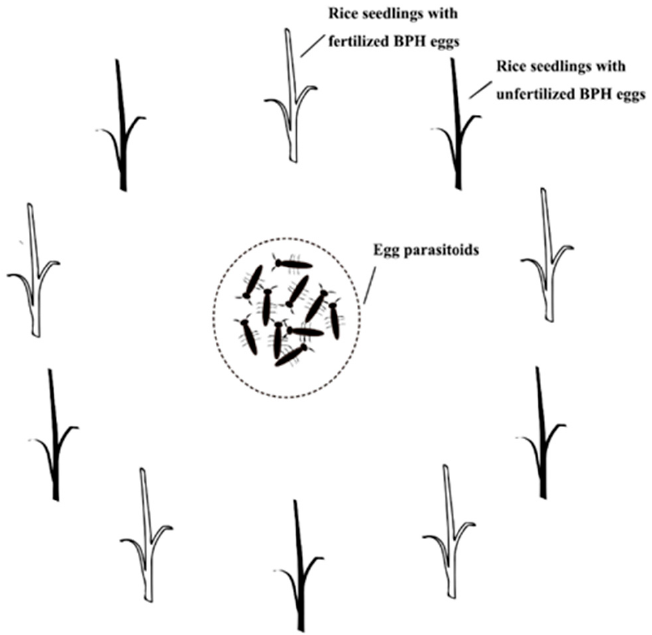
Figure 1. Experimental illustration of the parasitism preference of egg parasitoids between fertilized and unfertilized BPH